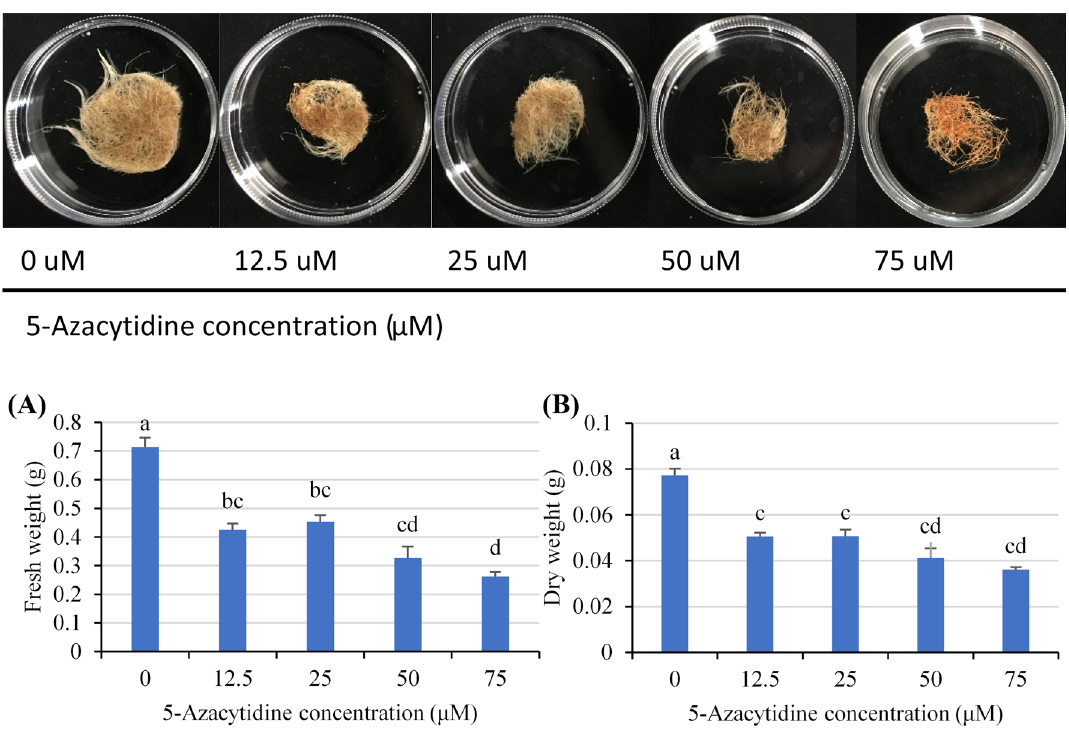
Figure 1. Influence of different concentrations of 5-azacytidine on Salvia miltiorrhiza hairy roots ( A ) fresh weight and ( B ) dry weight after 28 days of treatment. The values are the mean of at least three replicates ± S.E. Different letters indicate significant differences at the 5% level according to the LSD